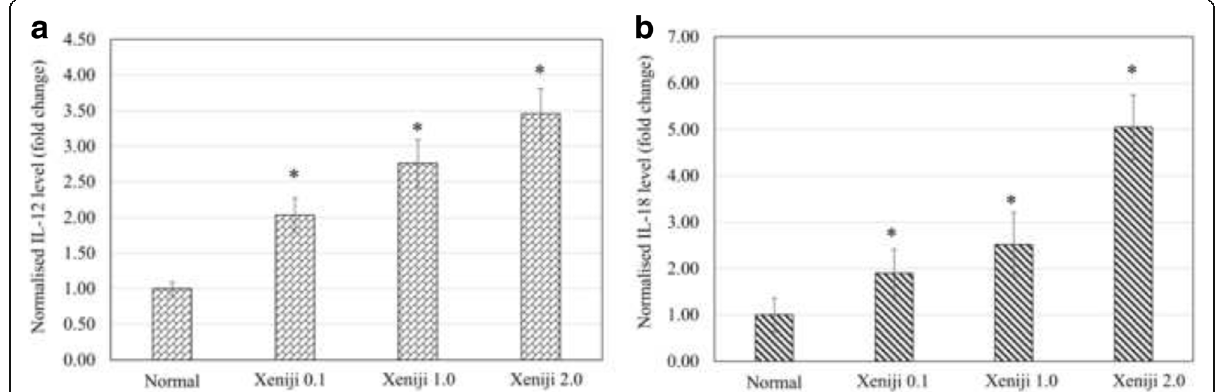
Fig. 3 Differential expression of ( a ) IL-12 and ( b ) IL-18 genes in spleen of normal and Xeniji (0.1, 1 and 2 g/kg body weight) treated mice. The expression of target genes (±SEM) were normalised to β -actin and the normal group was used as control for comparison. Fold change >2 comparing to normal control group was considered as significant*